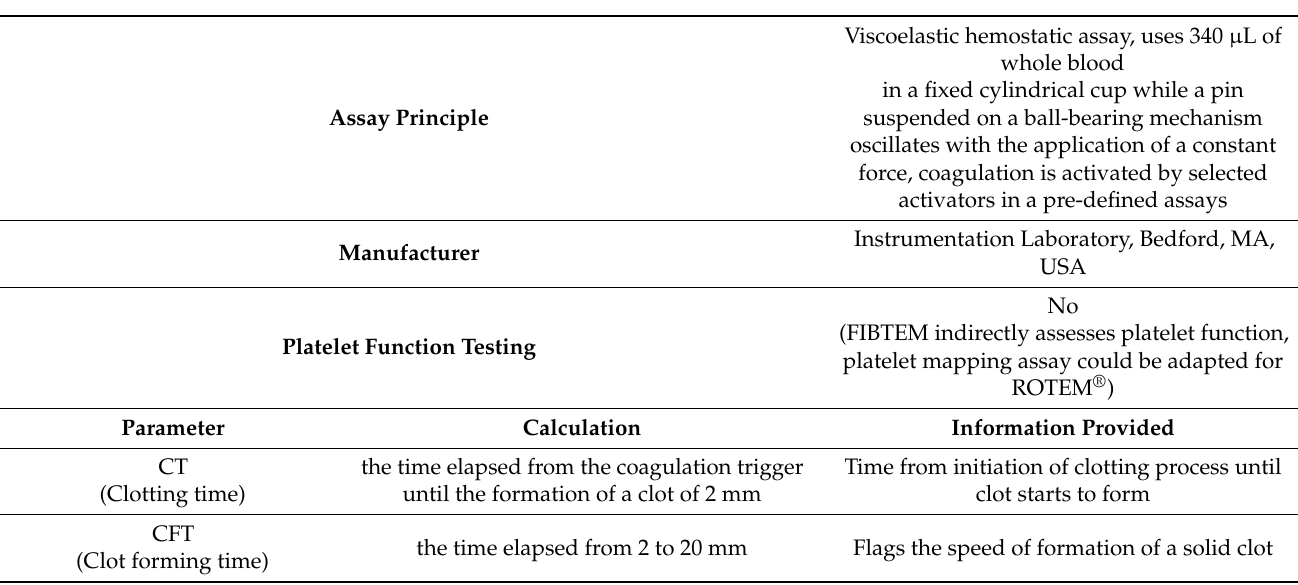
Table 2. Rotational thromboelastometry (ROTEM ®